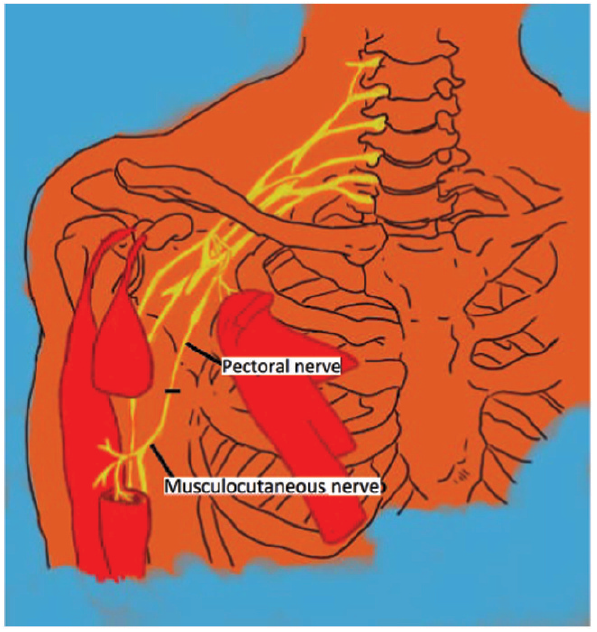
Figure 3 - Medial pectoral nerve to musculocutaneous